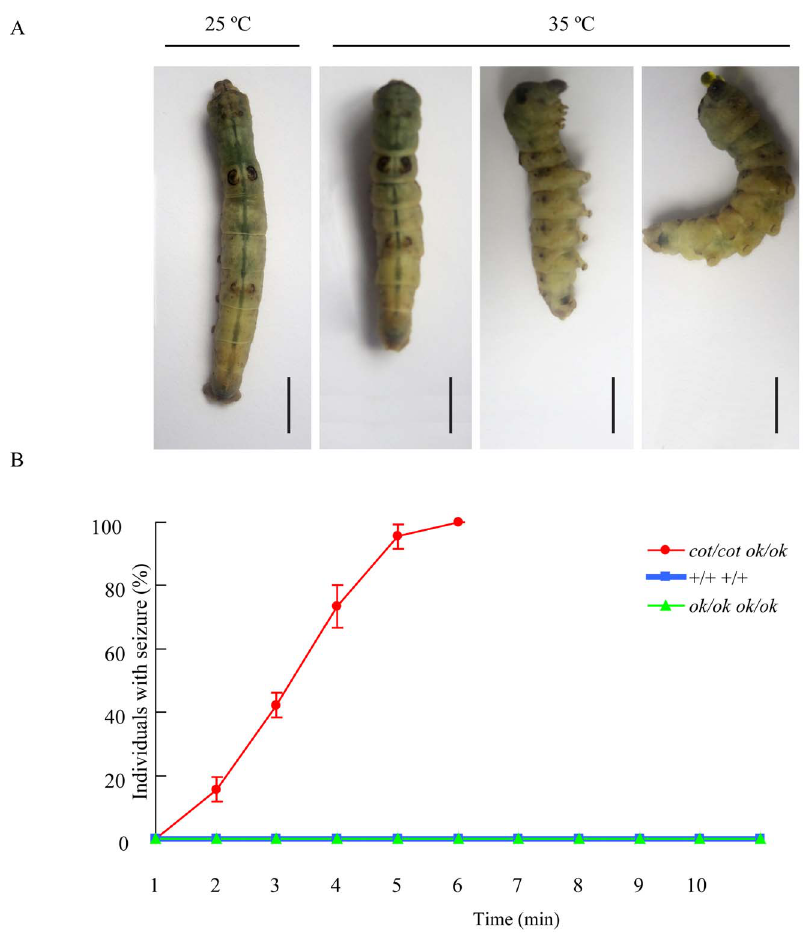
Figure 2. The cot mutant ( cot/cot ok/ok ) shows a temperature-induced seizure phenotype. (A) The seizure phenotype of cot mutants ( cot/cot ok/ok ) treated at 35 ˚ C for 10 min. (B) The behavioral response to hyperthermia in the cot/cot ok/ok , + / + ok/ok and + / + + / + strains. Seizures were defined as a period of body contact, followed by failure to maintain standing posture, with rolling, vomiting gut juice and occasional temporary absence of movement. Individuals at day 5 of the fifth instar (n 5 15 per strain) were immersed in a temperature-controlled electrothermal incubator (35 ˚ C, 10 min). The status of individual flies was determined at 1 min intervals and the cumulative number of individuals with seizure was determined at each time point for each strain. Data are presented as the means ¡ SEM.